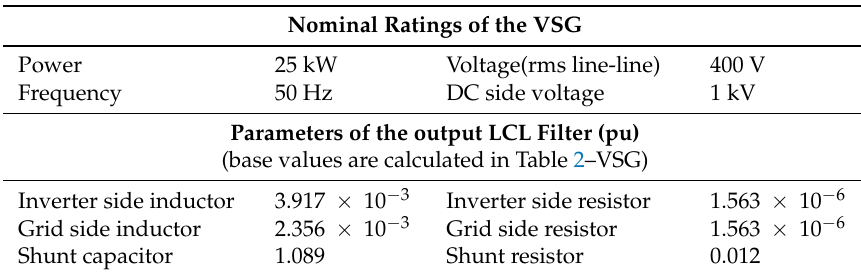
Table 7. Parameters of the VSG in the microgrid.